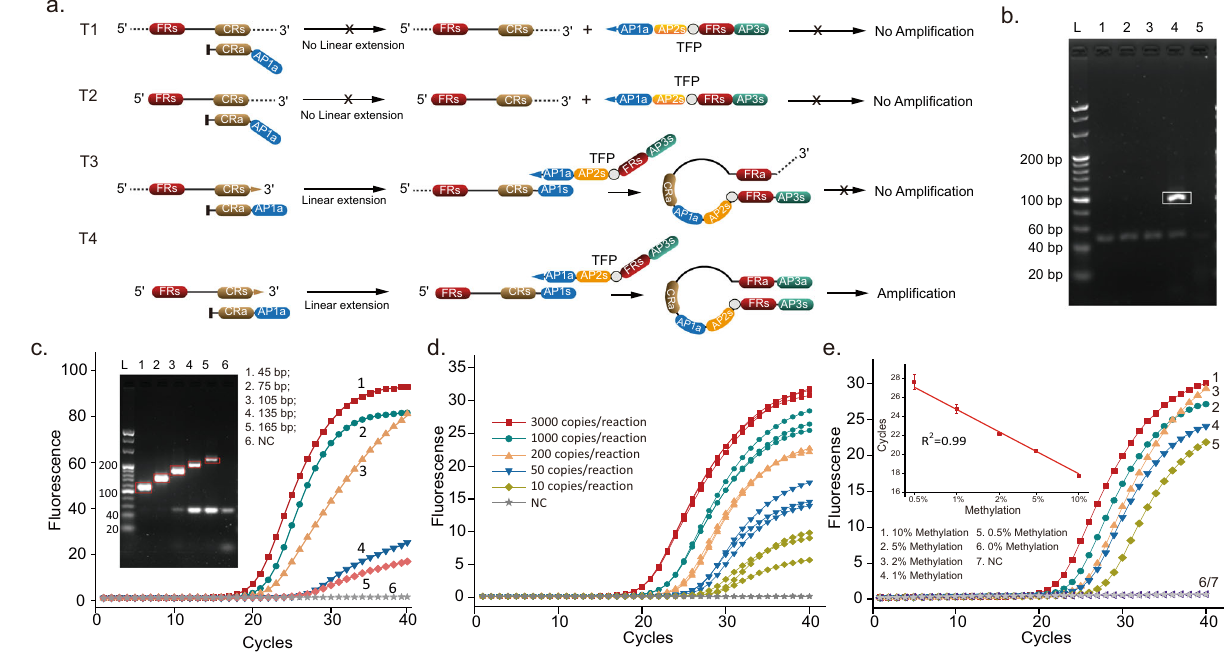
Fig. 6 | STEM-PCR for different arbitrary breaks. a Mechanisms for three dif- ferent arbitrary breaks with different distances to 3 ′ and 5 ′ ends. T1 indicates no breaks attwoends. T2and T3refer to fragments witha break onlyat5 ′ end and 3 ′ end,respectively.T4isthefragmentwithtwospeci fi cends; b Methylated SEPTIN9 sequences were treated with two different MDREs to generate speci fi c 3 ′ and 5 ′ end,respectively.GlaIfor5 ′ end,whileLpnPIfor3 ′ end.(1)noMDREs;(2)GlaIonly; (3) LpnPI only; (4) GlaI and LpnPI; (5) ddH 2 O as negative control. The band in a white box indicates the expected amplicon (100bp); each experiment was repe- ated independently at least three times with similar results. c STEM-PCR ampli fi - cationresultsof fi vearti fi cialmethylatedfragmentswithdifferentP1lengthsusing the same primer set, using GlaI. (1) 45bp (red); (2) 75bp (green); (3) 105bp (yel- low); (4) 135bp (blue); (5) 165bp (magenta); (6) ddH 2 O as negative control (gray).